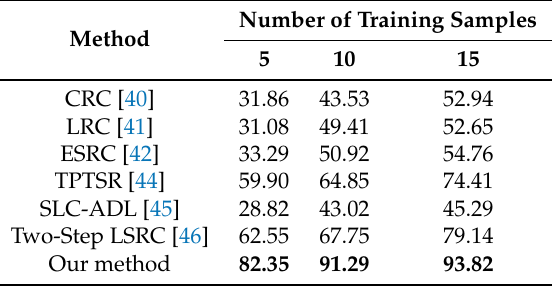
Table 4. Face recognition rates ( % ) of different methods on PIE database.